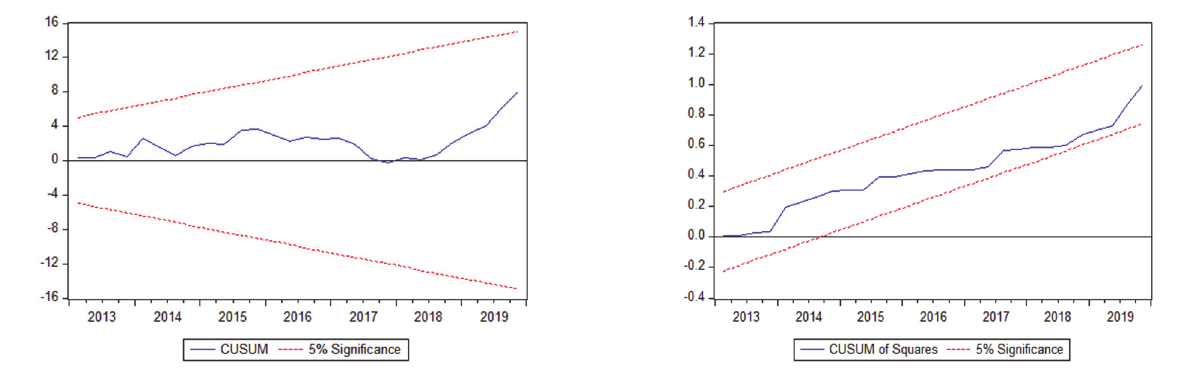
Fig. 5. CUSUM and CUSUM of Square for ARDL Model of Tourism, Hotel and Recreation